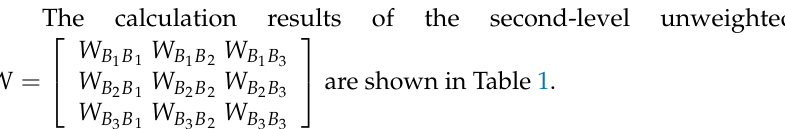
are shown in Table 1.